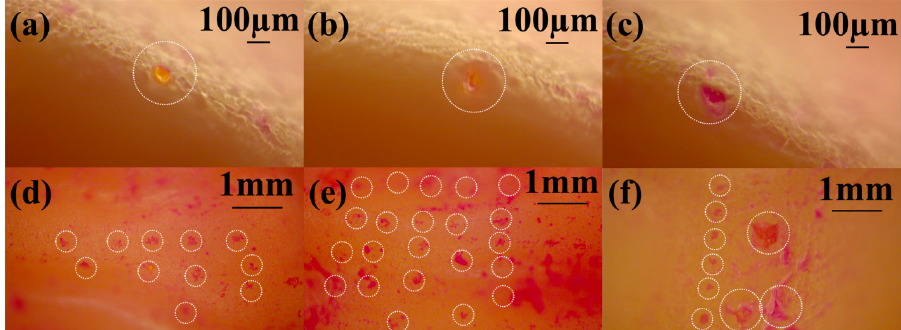
Figure 16. Optical micrographs of MN puncture characteristics on artificial skin—( a – c ): Individual microneedle puncture characteristics at different forces of 0.5 N, 10 N and 30 N respectively; ( d – f ) MN array penetration characteristics at different forces of 0.5 N, 10 N and 30 N respectively.